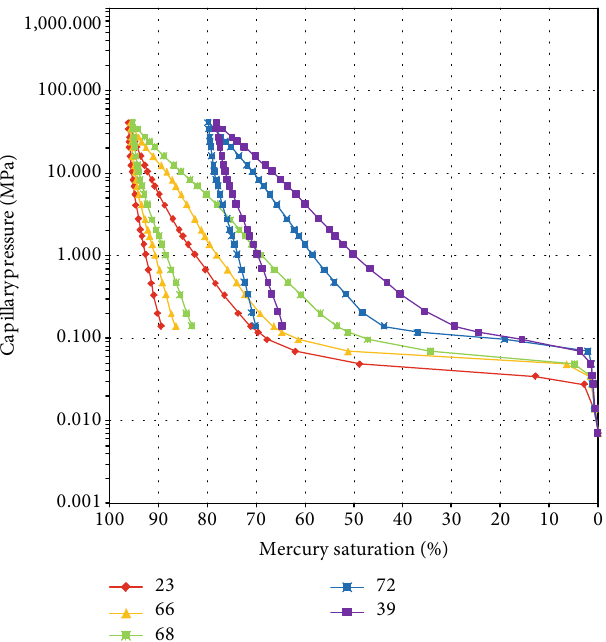
Figure 10: HPMI-derived capillary pressure curves of the fi ve selected